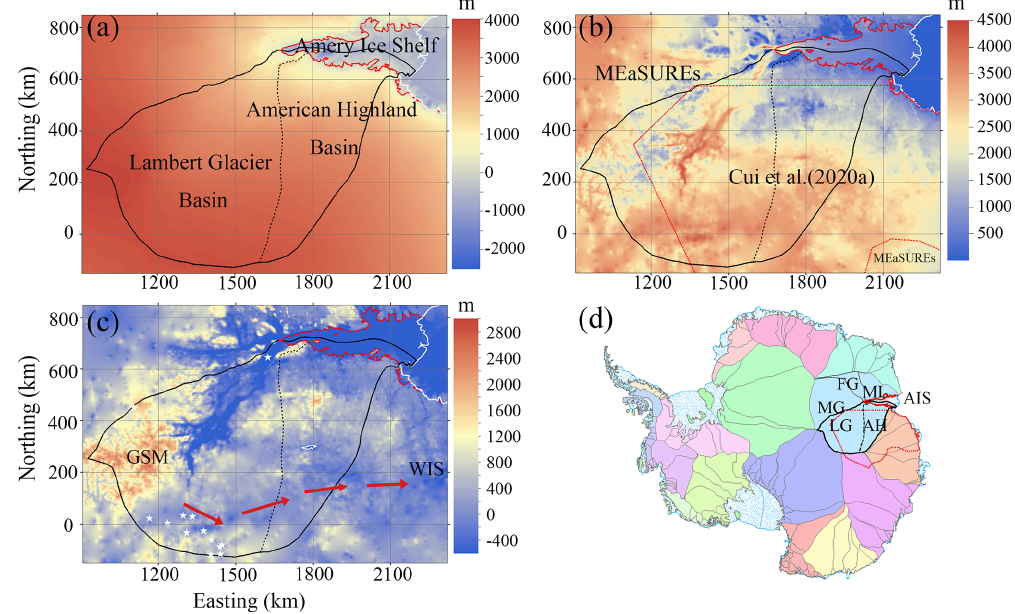
Figure 1. The domain topography and location with domain boundary overlain. (a) Surface elevation. (b) Ice thickness. (c) Bed elevation. (d) The location of our domain in Antarctica. The solid black curve is the outline of the study domain, including the central streamline of Amery Ice Shelf and the boundary of inland subbasins based on drainage basin boundaries defined from satellite ice sheet surface elevation and velocities (Mouginot et al., 2017; Rignot et al., 2019). The solid red and white curves in panels (a) – (c) are the grounding line and margin of Antarctic, respectively (Morlighem et al., 2020). The dotted black curve is the dividing line between Lambert Glacier basin and the American Highland basin. The dotted red curves in panels (b) and (d) are the boundary of ice thickness data from Cui et al. (2020a), inside which we incorporate data from Cui et al. (2020a) and outside from MEaSUREs BedMachine Antarctica, version 2. The white stars in panel (c) denote the locations of observed subglacial lakes (Wright and Siegert, 2012; Cui et al., 2020b), and the region within the white line at (1800 ◦ E, 300 ◦ N) is potentially the second-largest subglacial lake in Antarctic. The red arrows in panel (c) indicate the routing through the deep subglacial canyon system from GSM to WIS. The subbasins names of Lambert–Amery system are labelled in panel (d) , with ML for MacRobertson Land basin, FG for Fisher Glacier basin, MG for Mellor Glacier basin, LG for Lambert Glacier basin, AH for American Highland basin, and AIS for Amery Ice Shelf. Table 1. Datasets used in this